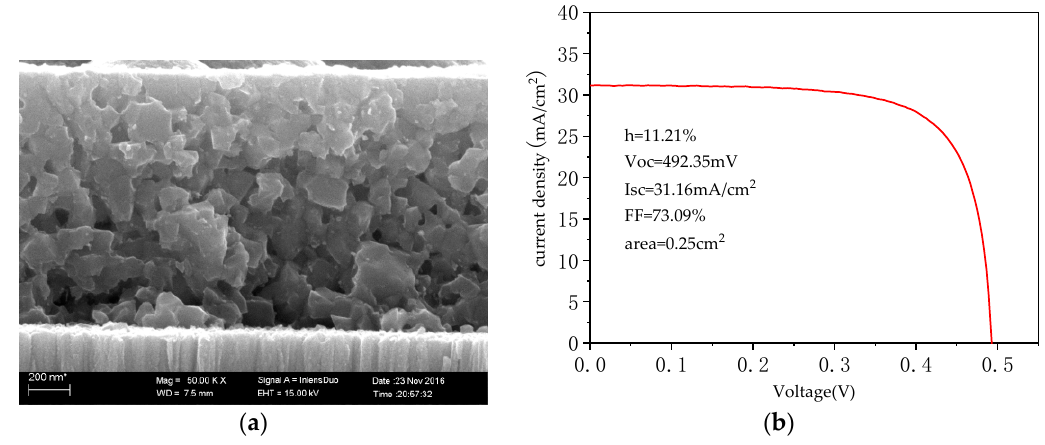
Figure 6. ( a ) The microstructure of CIGS absorber; and ( b ) the current–voltage performance curve.